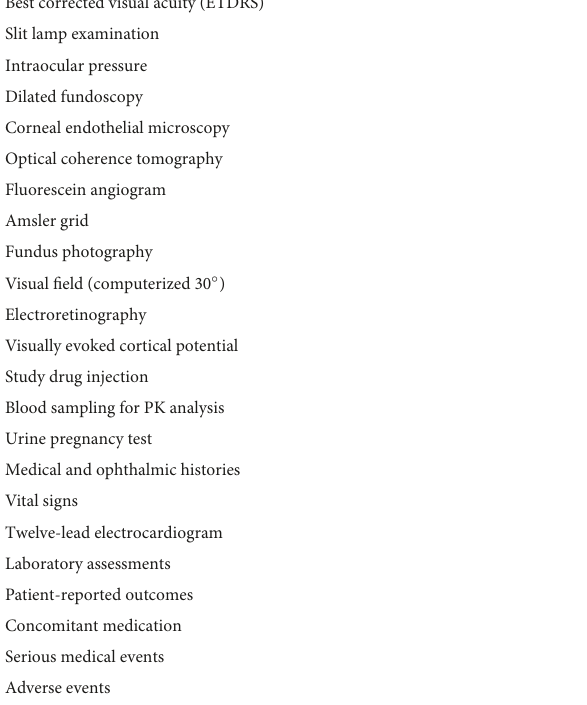
TABLE 1 List of assessments and